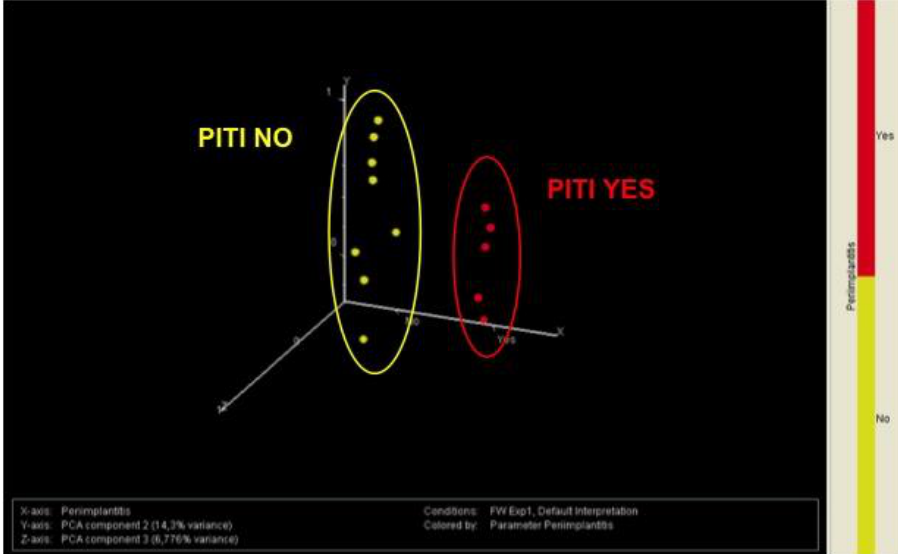
Figure 5. PITI occurrence as related to parodontal biotype.